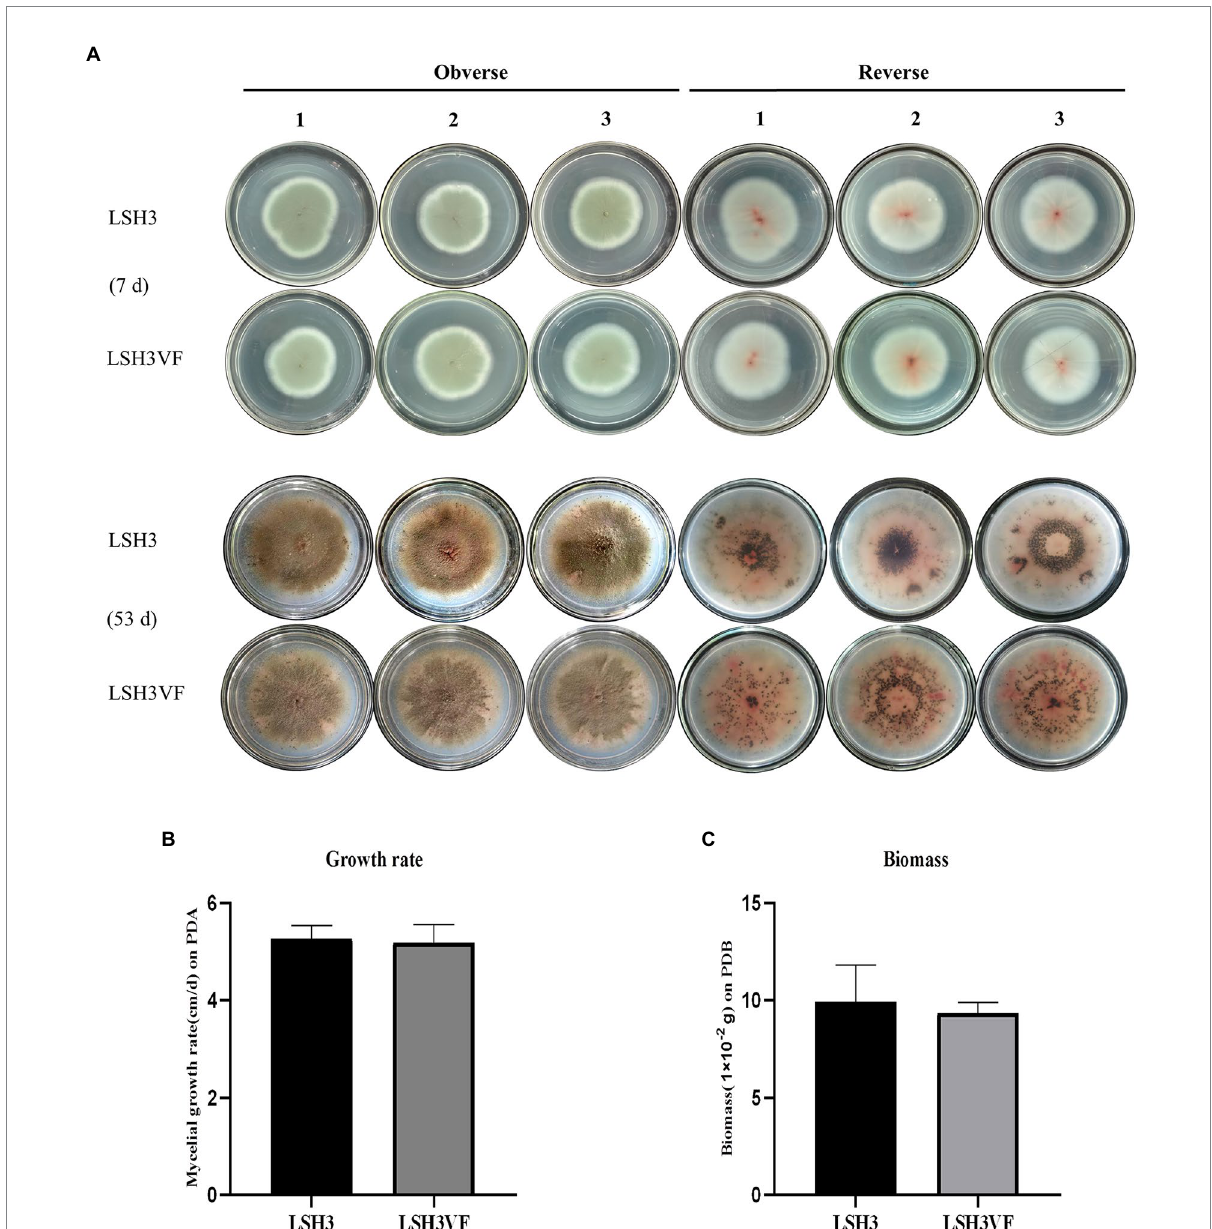
FIGURE 3 Biological effects of TaPmV-l on the virus-infected strain LSH3 and the virus-cured strain LSH3VF. (A) Comparison of the colony morphology formed by the virus-infected strain LSH3 and the virus-cured strain LSH3VF at 7 and 53 days, respectively. (B) Comparison of the growth of the virus-infected strain LSH3 and the virus-cured strain LSH3VF. (C) Comparison of biomass production in the virus-infected strain LSH3 and the virus-cured strain